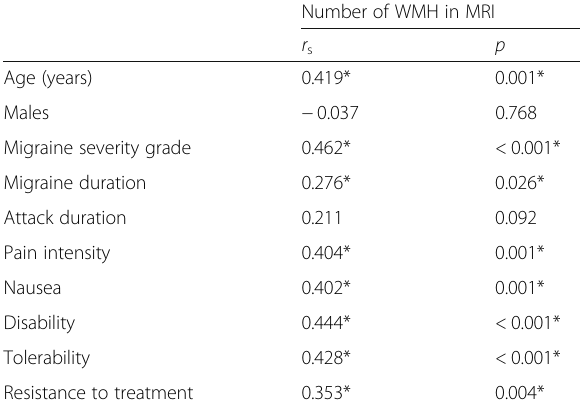
Table 6 Multivariate analysis of development of WMH among migraineurs